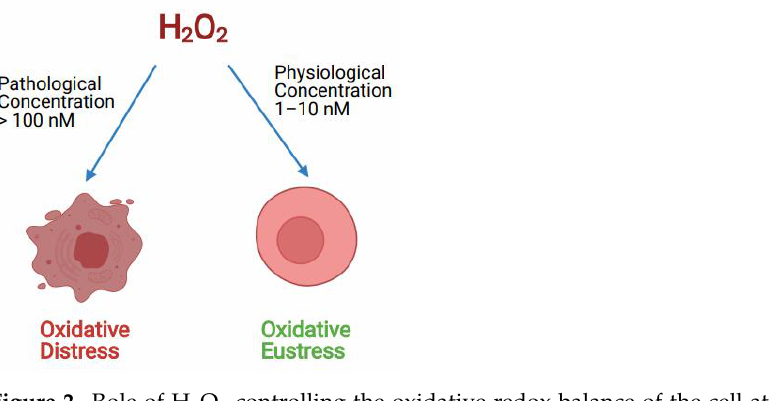
Figure 2. Role of H 2 O 2 controlling the oxidative redox balance of the cell at different concentrations. Hydrogen peroxide (H 2 O 2 ) controls the cell signaling process at physiological concentration called oxidative Eustress. Whereas, at pathological concentration, H 2 O 2 causes cell death due to oxidative distress.